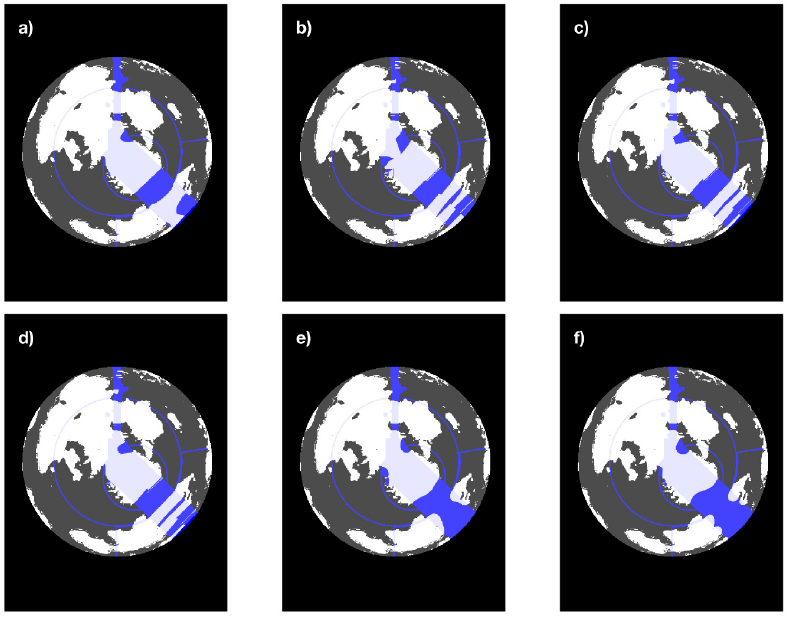
Figure A1. TSI cloud mask for a sample image with 160° FOV captured on 14 June 2017 17:29:30. The cloud mask includes interpolated image region with blue shading using ( a ) natural interpolation, ( b ) nearest neighbor, ( c ) linear interpolation, ( d ) cubic interpolation, ( e ) 8-neighbor average, ( f ) Laplacian ∇ 2 interpolation. Interpolation over the camera arm (vertical line to the top of the image) and green lines (Figure 1c) appears robust. Artifacts introduced in the shadowband region (diagonal line to the lower right) depend on interpolation method